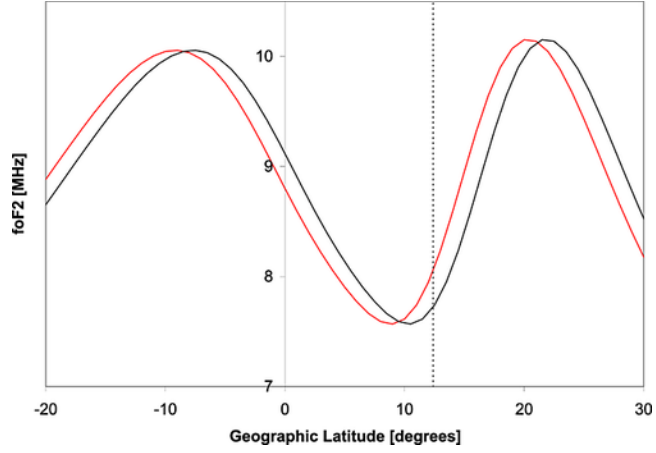
Figure 2. Latitudinal profile of foF2 at the geographic longitude of Ouagadougou (358.5° E) obtained with the International Reference Ionosphere model, IRI2007, as an example for January, at 12 LT, and solar activity level corresponding to F10.7 = 150 (red line). foF2 profile displaced according to the displacement of the magnetic dip equator at the Ouagadougou longitude (black line). The dotted vertical line indicates the latitude of Ouagadougou. (Reproduced from Gnabahou et al. [50]: Figure 5). In both works, [50,52], results for Huancayo (12.0 ◦ S, 284.7 ◦ E) and Phu Thuy (21.03 ◦ N, 105.96 ◦ E) obtained by Upadhyay and Mahajan [53] and Pham Thi Thu et al. [54], respec- tively, are also explained in terms of the EIA latitudinal profile displacement. Huancayo is, like Ouagadougou, an equatorial ionospheric station north of the dip equator, but in the southern hemisphere. The dip equator is moving away from the station, so an increase in foF2 should be expected as the trend obtained by Upadhyay and Mahajan [53]. In this case the positive trend is also in agreement with the decrease of the sin(I)cos(I) factor at the corresponding